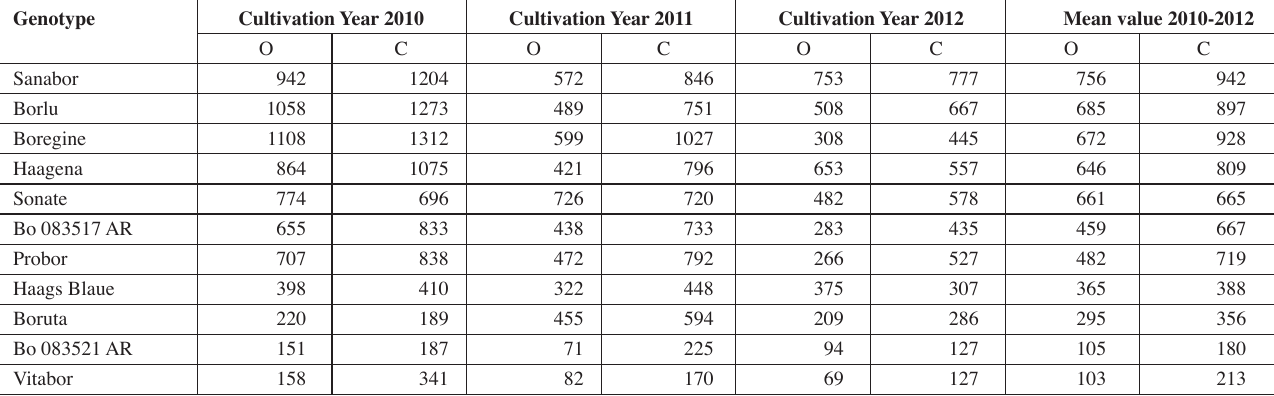
Tab. 2: Alkaloid content [μg g -1 ] of nine varieties and two breeding lines of organic (O) and conventional (C) cultivated sweet narrow-leafed lupins in three years.